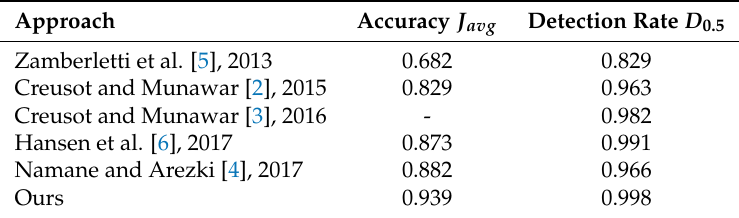
Table 2. Test results on the WWU Muenster Barcode Database.